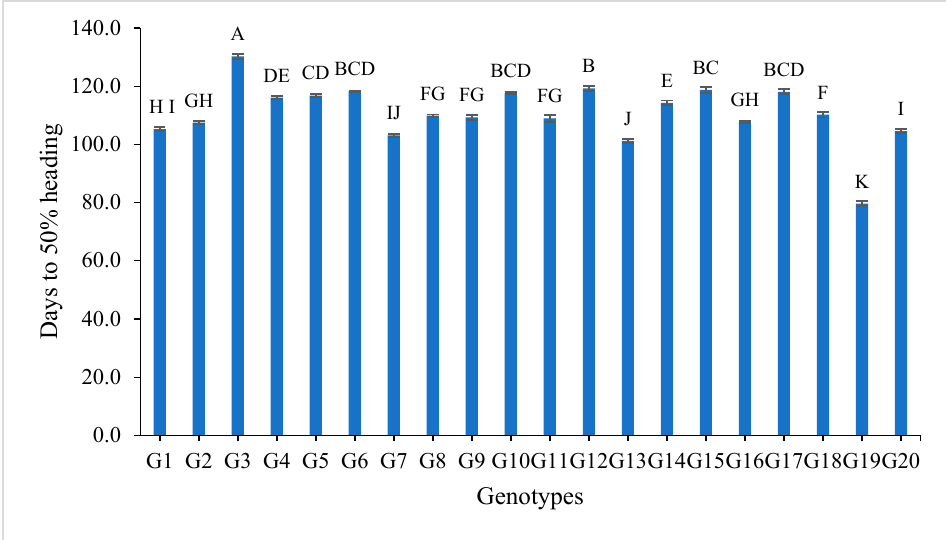
Figure 1. Mean values of days to 50% heading of twenty rice genotypes over the two years. Bar represents the standard deviation. Different alphabetic letters represent the significant differences among the genotypes at p < 0.05, based on Duncan’s multiple range test.